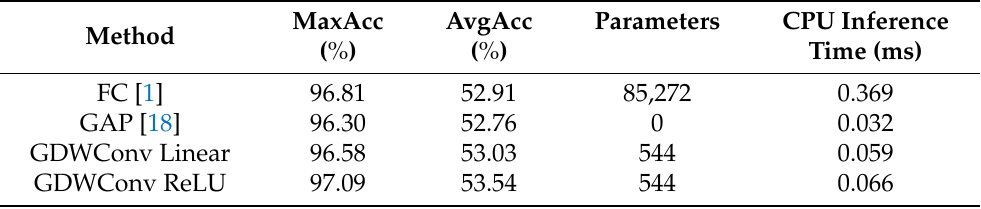
Table 7. Performance comparison with different feature reconstruction methods on RadioML2018.01A